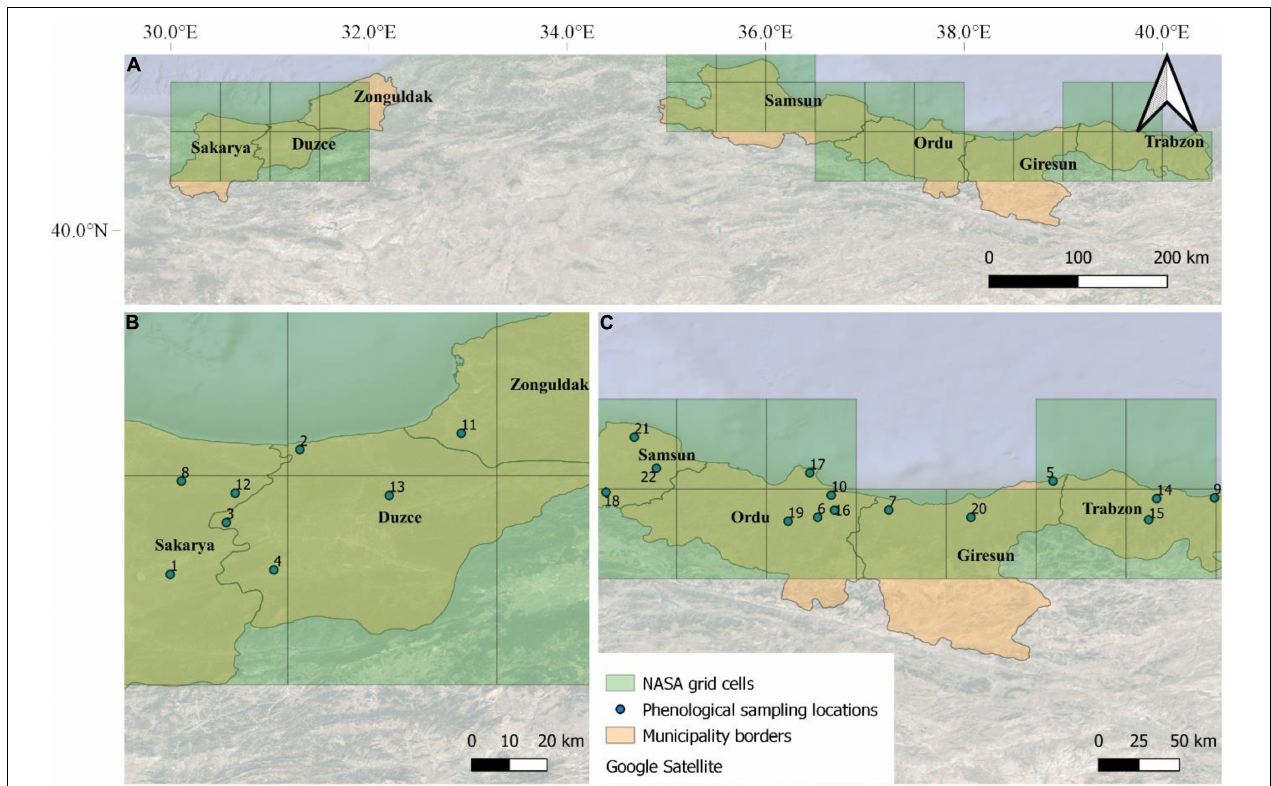
FIGURE 2 | The seven main municipalities where hazelnuts are cultivated in Turkey (A) . The locations of the 22 orchards where phenological observations were performed on a weekly basis in the Western (B) and Eastern (C) Black Sea are overlapped with NASA-POWER grids (27 grid